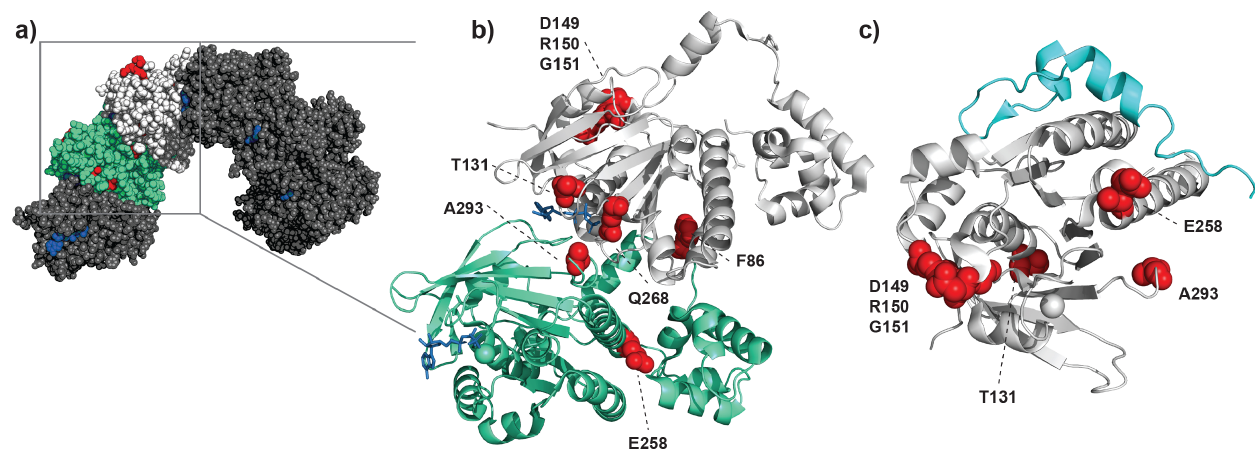
Figure 1. Overview of RAD51 structures and interactions. Overview of RAD51 mutations mapped onto structures based on PDB ID 5NWL 15 and 1N0W 26 . ( a ) Model based on the crystal structure of a heptameric right-handed RAD51 nucleoprotein filament. Two adjacent protomers are colored green and light gray; the other five protomers are shown in darker gray. ATP is highlighted by the blue areas at the interfaces of distinct protomers, and sites of mutation are highlighted in red. The red patch on the top of the white-colored protomer is the patch of amino acids 149–151 that is assumed to affect interaction of RAD51 with other binding partners. Note that Q272 is not highlighted in the figure, as that residue was not resolved in the crystal structure. ( b ) Focus on the interface between two protomers, where ATP is shown in blue and the discussed sites of mutation are highlighted with red spheres. Most of these mutations can be found at the direct interface between the two protomers and thus close to the nucleotide-binding pocket. ( c ) Interaction of RAD51 (light gray) with a BRCA2 BRC repeat (cyan). The locations of mutation discussed are highlighted in red. Here, one mutation is in close proximity of the binding region with the BRC repeat (E258) and therefore might impair RAD51 binding by